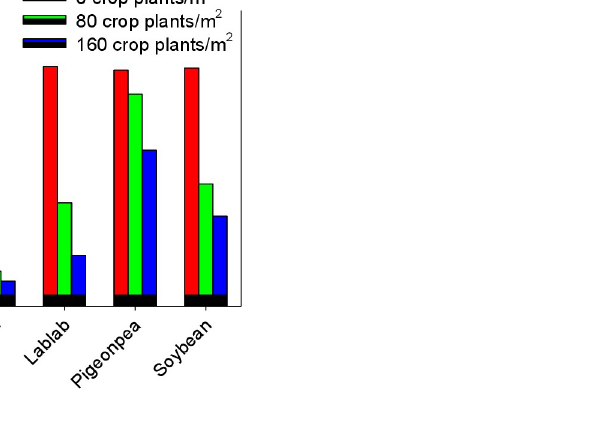
Fig 2. Leaf number of Echinochloa colona when it was grown alone or in interference with 80 and 160 plants m -2 of various cover crops.